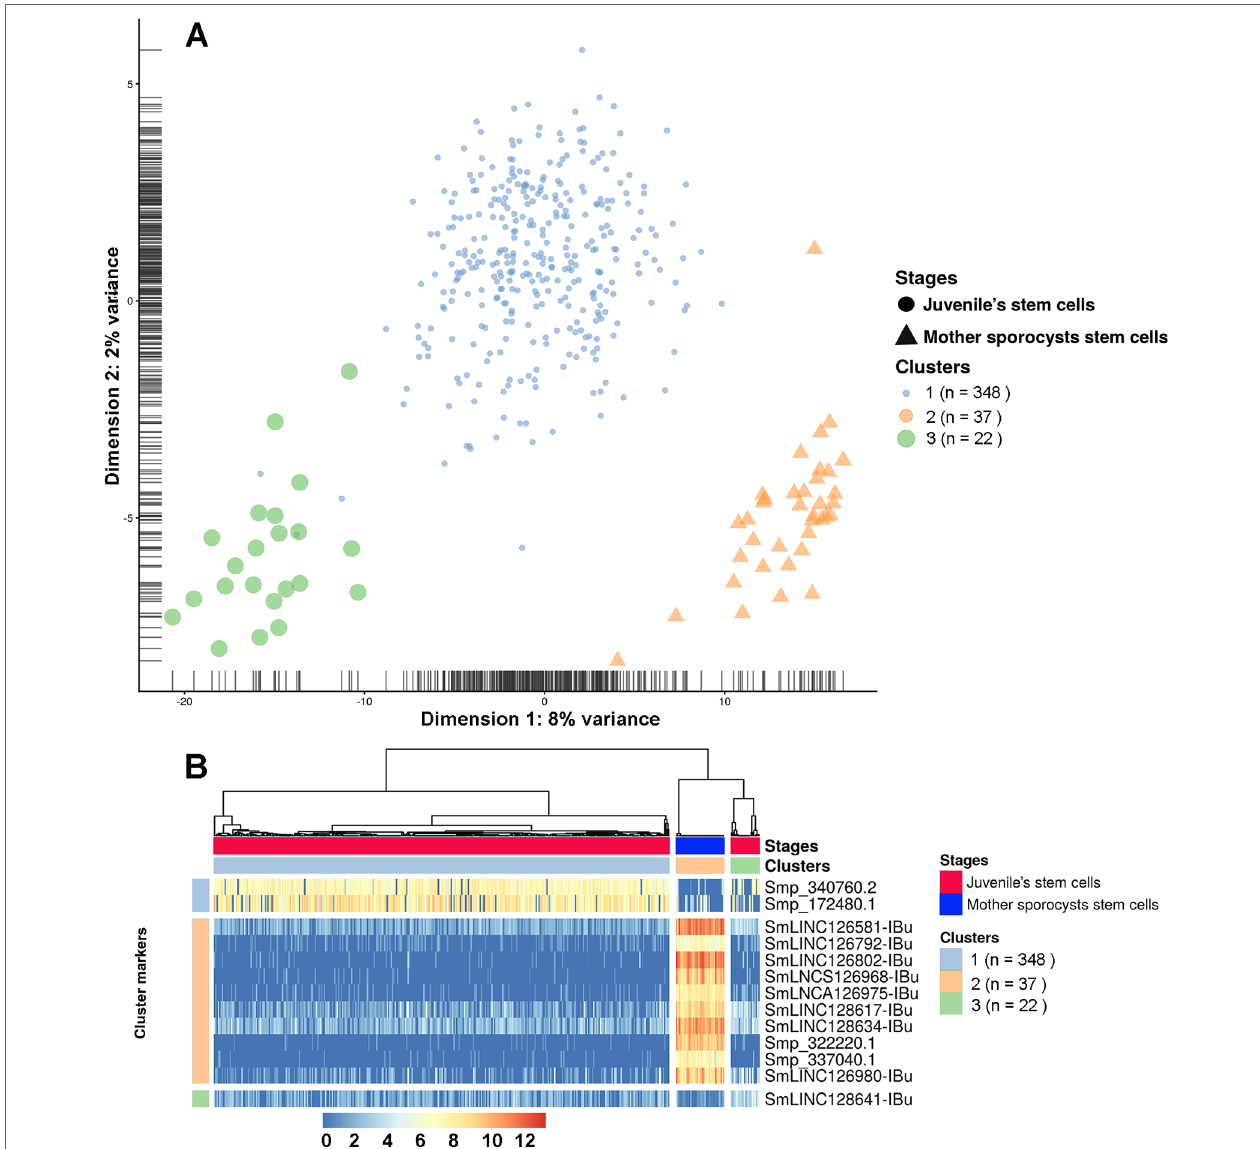
FIGURE 13 | Single-cell expression analysis identified three different cell population clusters when comparing S. mansoni juveniles’ stem cells and mother sporocysts stem cells and lncRNAs as gene markers at the single-cell level. (A) Single-cell RNA-Seq data from two RNA-Seq libraries, one from juveniles’ stem cells and another from mother sporocysts’ stem cells, were analyzed with the SC3 tool that performed an unsupervised clustering of the cells based on the single-cell gene expression data. Principal component analysis plot, where the symbol colors and sizes indicate the three clusters identified by SC3, and the shapes indicate the two life-cycle stages from which the stem cells were isolated. The symbol size is inversely related to the number of cells that belong to the cluster. (B) In the marker-gene expression matrix (log-transformation, represented by the color scale), the statistically significant gene markers are the rows, and the cells are columns. The life-cycle stage from which each cell was isolated is indicated by the color bar at the top (stages). The clusters of cells are separated by white vertical lines and are indicated by the second color bar at the top (clusters). The cluster marker genes are separated by white horizontal lines, the markers groups are indicated at left, and the names of the marker genes at right. Only the top 10 most significant marker genes are shown for cluster